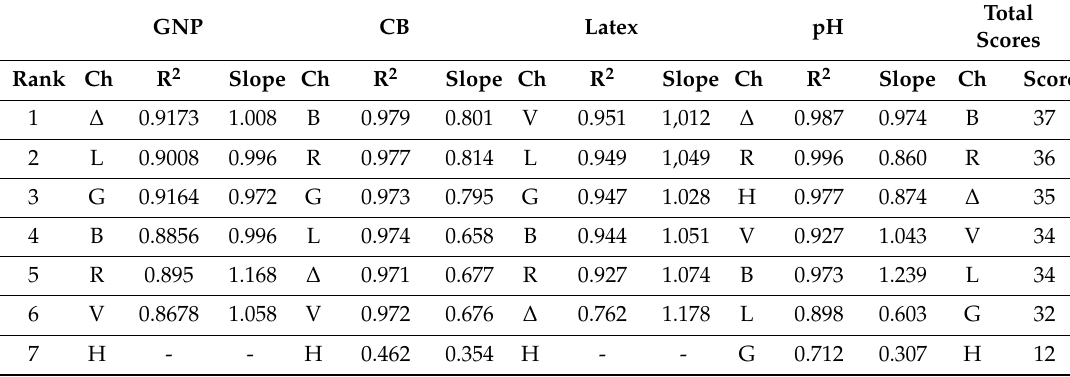
Table 2. Slopes and R 2 scores of log–log regression functions fitted to predictions of GNP, CB, LNP concentrations, and pH values shown in the scatter plots of Figure 6. A scoring system was used to attribute scores to R 2 and slope values for each channel (see Section 2.8). Scores (Table 3) determined ranks for each color system, as well as total scores per channel. ∆ is ∆ RGB. Ch is channel.